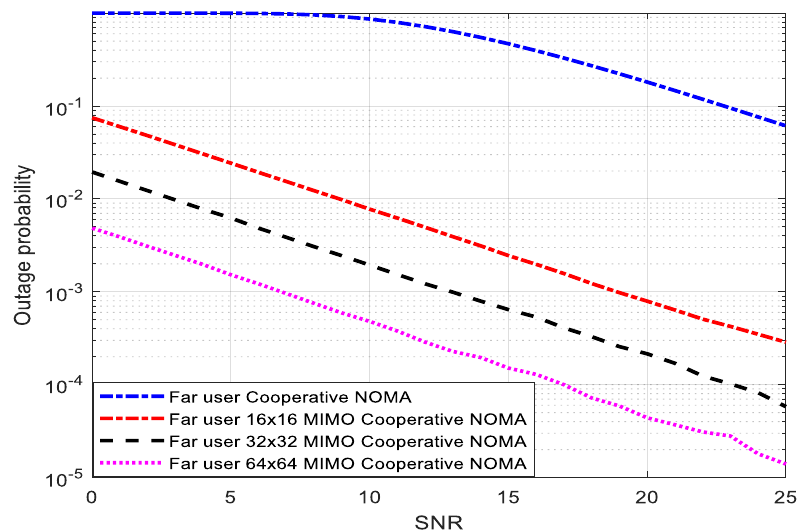
Figure 8. Outage probability against SNR for four different far users (cooperative NOMA and MIMO–cooperative